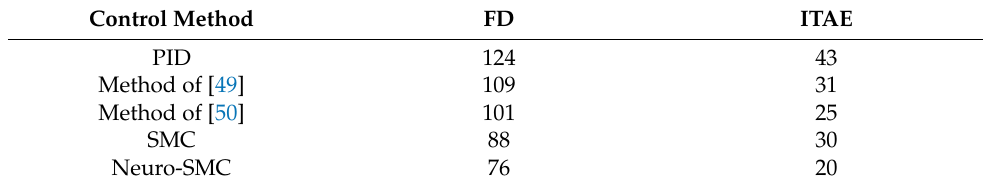
Figure 8. Comparison of generator speed changes (Third case).